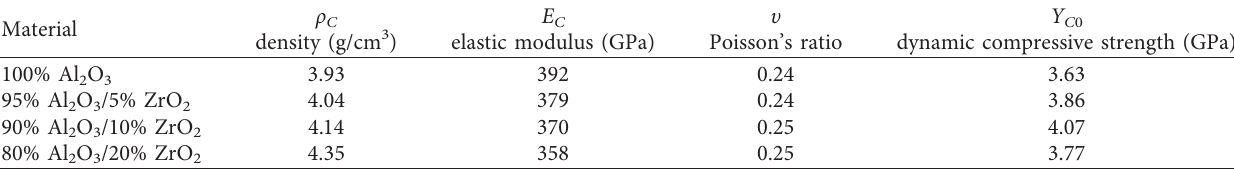
Table 3: Parameters of the materials of each layer of the ceramic structure [9].